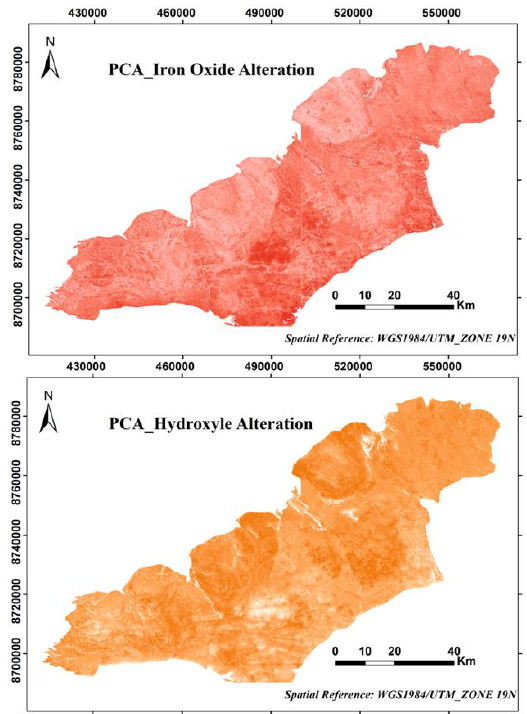
Figure 4. FeO and OH alteration Maps based on PCA technique; pixels with high colour intensity mark target